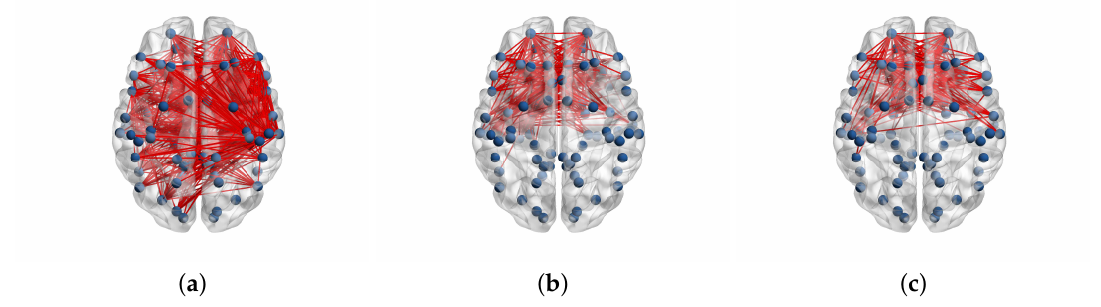
Figure 6. Connections between ROIs for 173 electrodes of: ( a ) CNT, ( b ) MCI and ( c )